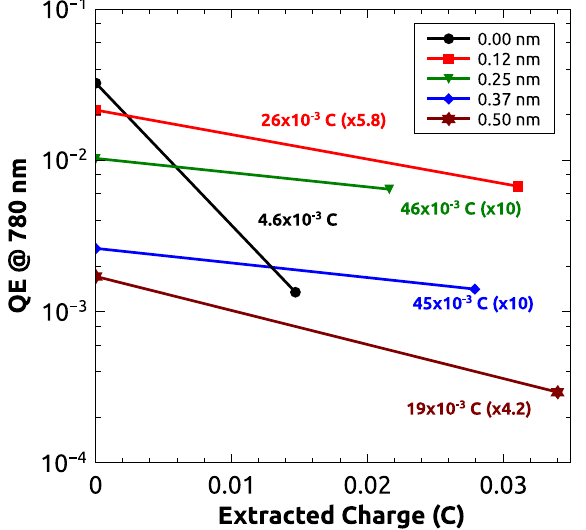
FIG. 7. QEs measured at 780 nm before and after the lifetime measurements that are reported in Fig. 6. From the QE measurements at 780 nm we can estimate the lifetimes as function of the extracted charge and relative gains with respect to the Cs-o activates sample. These values are provided alongside the data. Estimated lifetime gains are similar to the ones observed at